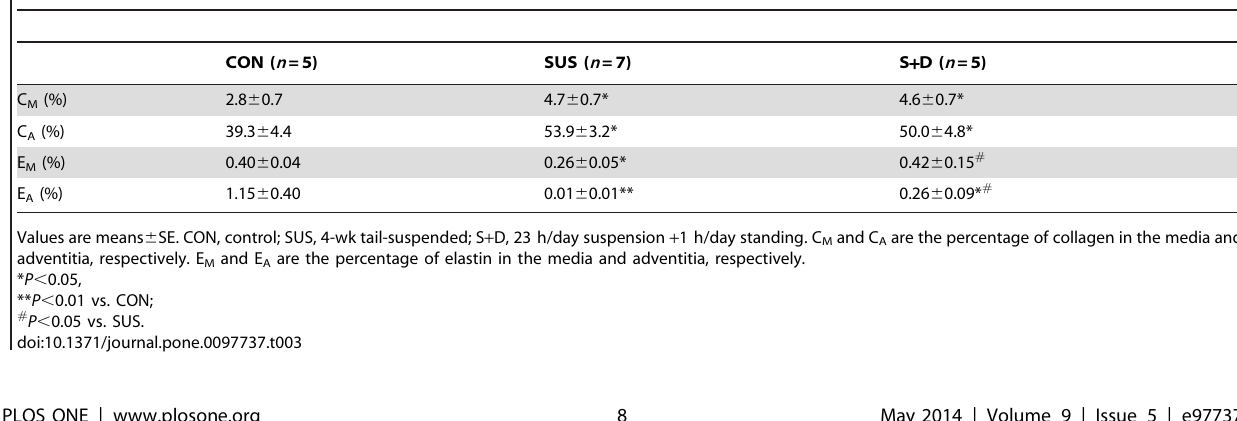
Table 3. Percentage of collagen and elastin in the wall of middle cerebral arteries of CON, SUS, and S + D